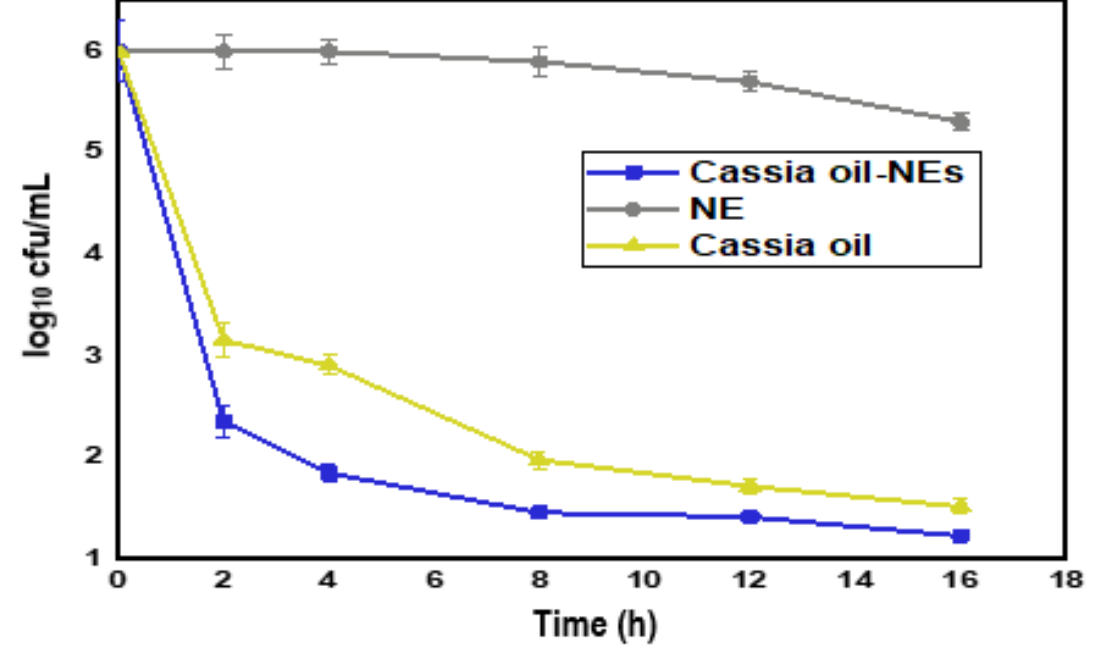
Figure 6. Comparative time-kill analysis of CEO, CEO-NE, and Figure 6 . Comparative time-kill analysis of CEO, CEO-NE, and NE.